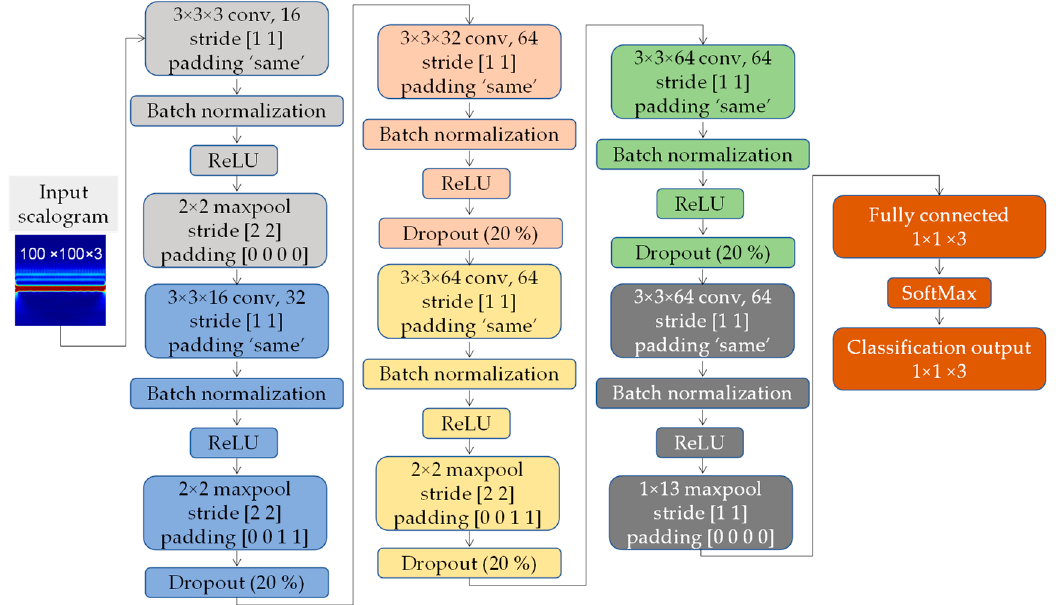
Figure 6. Architecture of the convolutional neural network used in the current study.